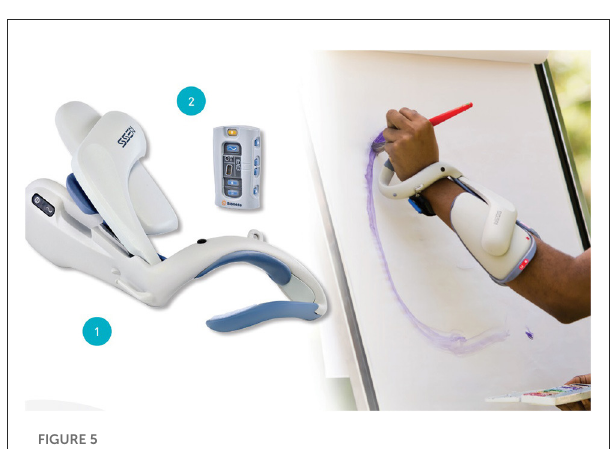
FIGURE5 FES of hand (Bioness H200